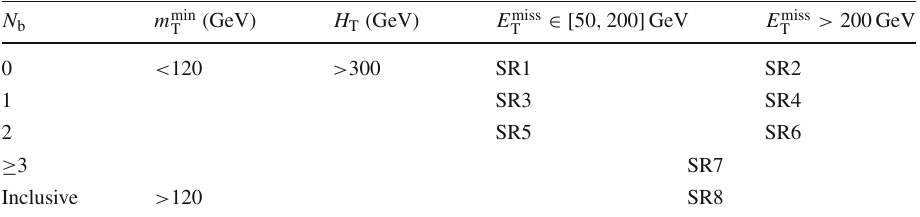
between SR3 and SR8 are included in SR3, with the exception of the regions to the right of SR34-37, which are included in those